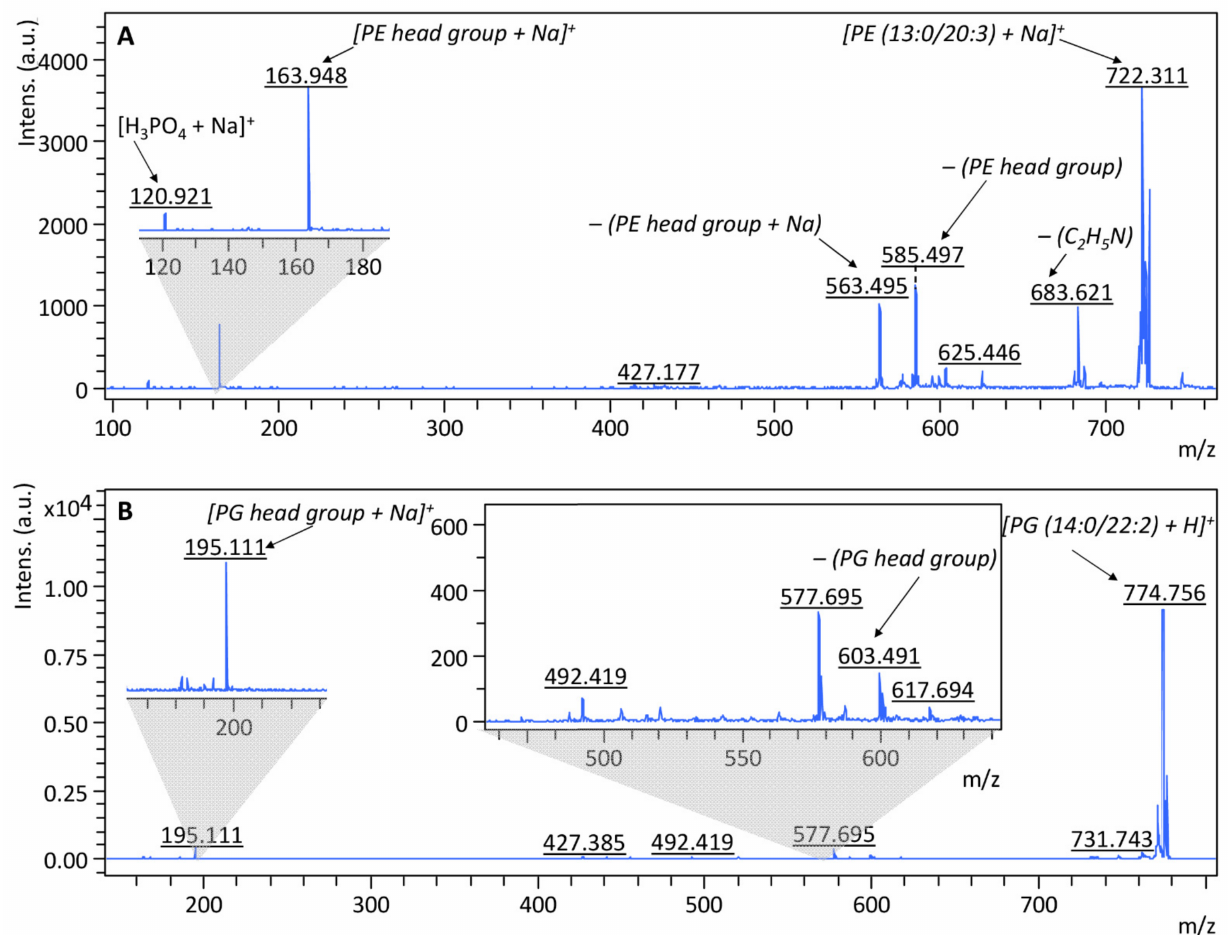
Figure 10. Fragmentation pathway and MS/MS spectra of signal at 722 ( A ) and 775 m / z ( B